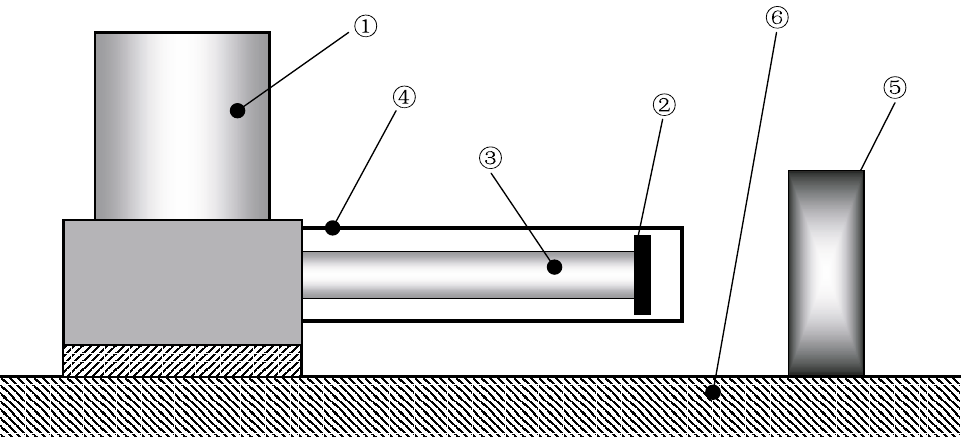
Fig. 2. Schematics of integrated electro-optic